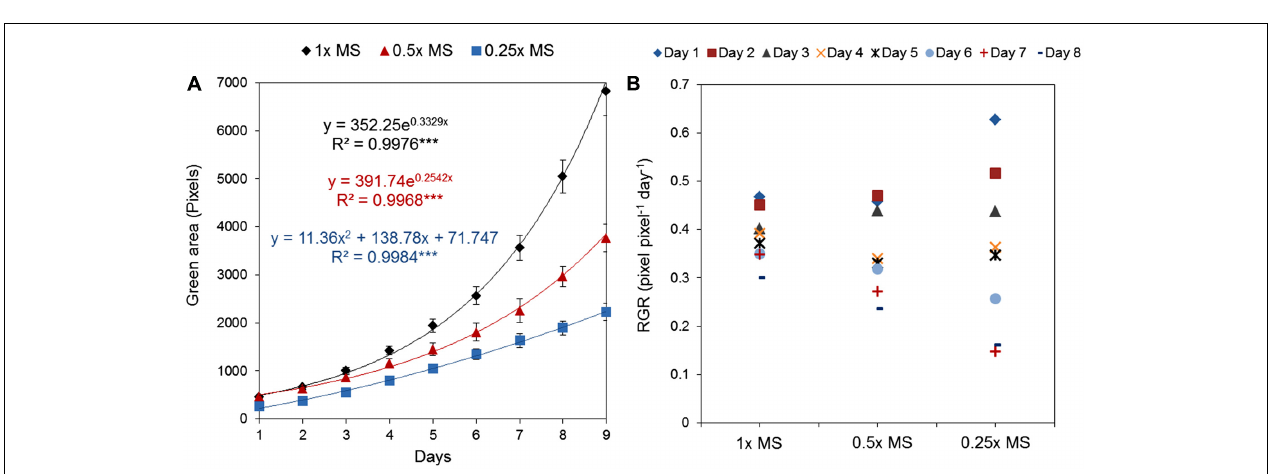
FIGURE 8 | Natural variation in Arabidopsis rosette growth in different MS media. (A) Green area (pixels) of 4 DAG Arabidopsis seedlings grown in 12-well plates ( n = 36) with different MS media for 9 days. Mean ± SE . The equations of the curves and the Pearson’s correlation coefficients with significance according to ANOVA after linearization were calculated. ∗∗∗ p < 0.001. (B) Relative growth ratio (RGR, pixel pixel − 1 day − 1 ) of 4 DAG Arabidopsis seedlings.